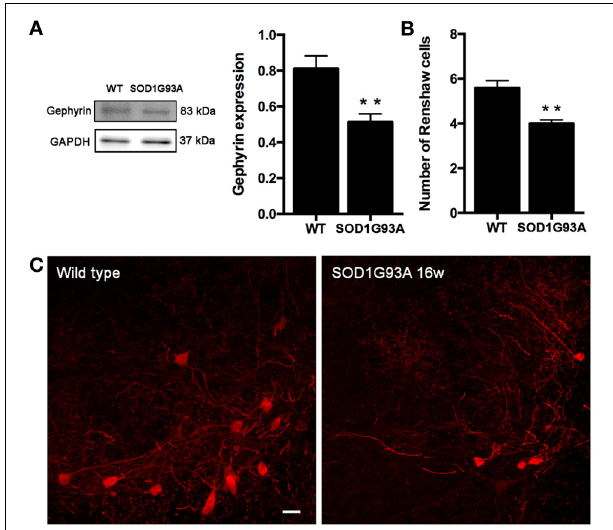
FIGURE 8 | Evaluation of inhibitory intraspinal circuits in SOD1 G93A mice at 16 weeks of age. (A) Representative blots and quantification of gephyrin expression in the ventral part of the lumbar spinal cord. Results revealed that gephyrin expression in 16 weeks old SOD1 mice was reduced when compared to wild type mice. (B) Number of Renshaw cells in the ventral horn of L4 spinal cord of wild type and SOD1 G93A animals at 16 weeks of age. Values are mean ± s.e.m. ∗∗ p < 0 . 01 vs. wild type animals. (C) Representative confocal images of Renshaw cells in the L4 spinal cord of wild type and 16 weeks old SOD1 G93A animals. Scale bar 10 µ